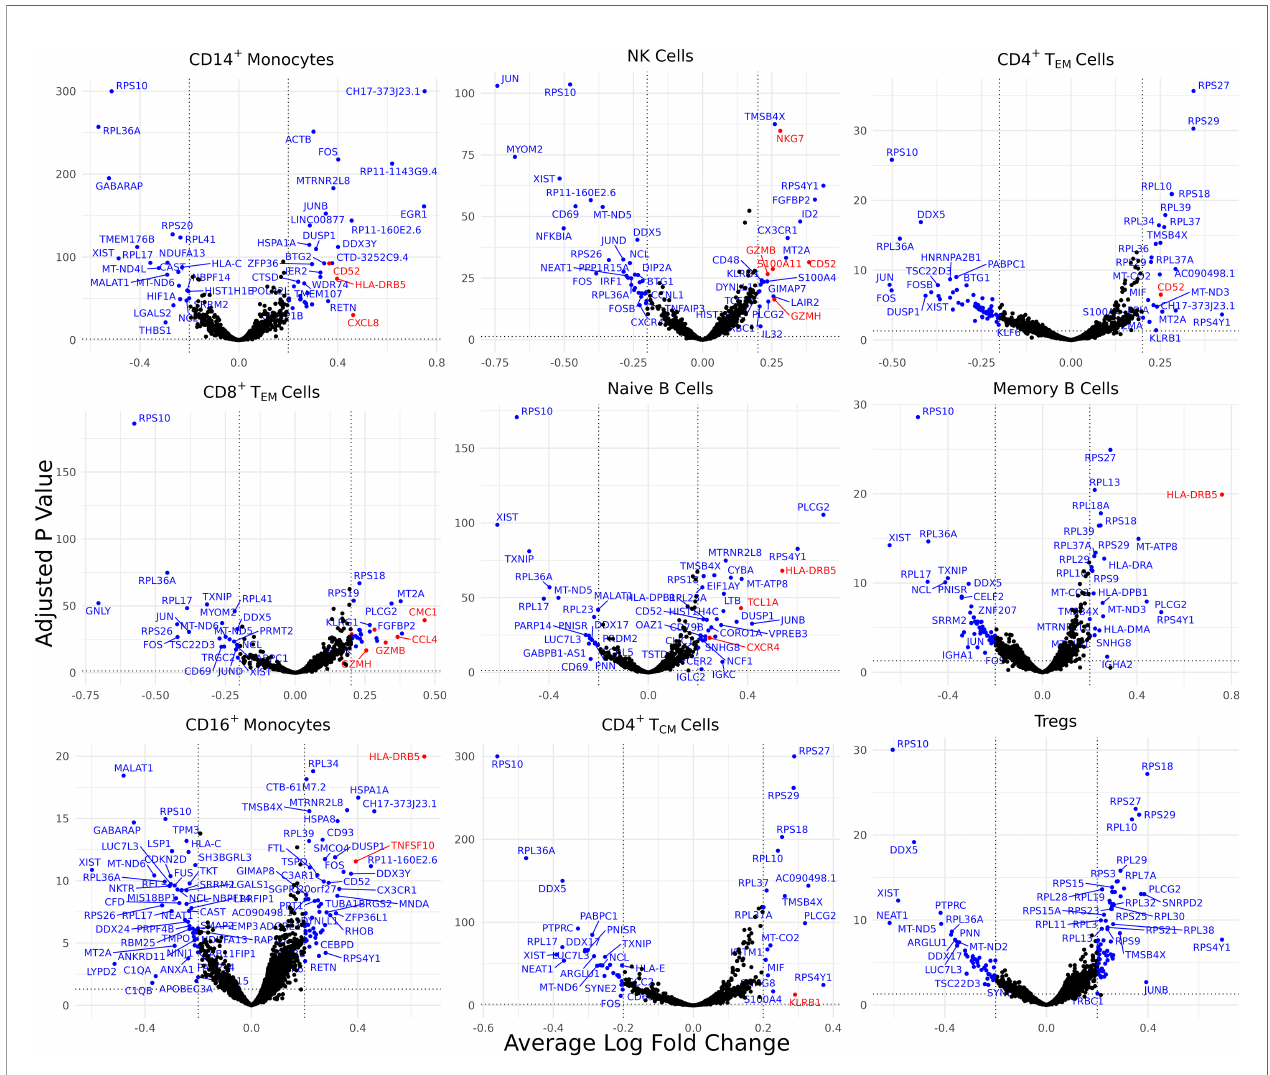
FIGURE 2 | Cell type-speci fi c DE genes between AS and healthy subjects. Volcano plots showing the DEGs for 9 cell types based on a Bonferroni-adjusted p-value < 0.05 and absolute average log 2 fold change ≥ 0.20. Blue points represent statistically signi fi cant genes and genes mentioned in the paper are highlighted in